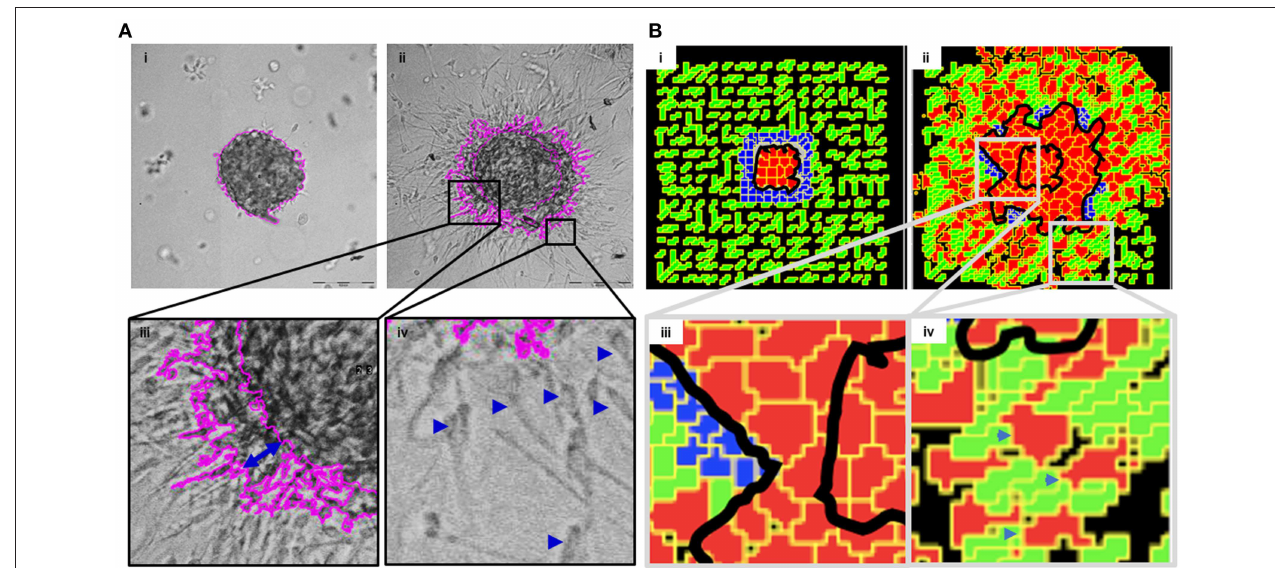
FIGURE 2 | Multiscale multicellular invasion of breast cancer cells in culture. (A) Representative phase contrast micrographs from time-lapse imaging of MDA-MB-231 cells showing multiscale invasion into fibrillar matrix. rBM-coated MDA-MB-231 clusters embedded within type 1 collagen (Ai) invade into the latter within 24h (Aii) . Cells show expansive migration [ (Aiii) ; double-headed blue arrow shows the extent of collective migration between initial boundary (0h) and final boundary (24h) of the cluster (boundaries shown in pink)]. Single mesenchymal cells are also observed in type 1 collagen [ (Aiv) right inset; blue arrowheads]. Scale bar: 200 µ m. (B) Multiscale invasion exhibited by computational model. Initial pattern [( Bi) ; MCS10; cancer cells (red) packed within a BM-like nonfibrillar matrix (blue) and further outward by fibrillar collagen-like matrix (green; inter-fibrillar gap = 3 unit pixels)], and final pattern [ (Bii) ; MCS 440] showing invasion of cells. In silico cells show expansive migration [ (Biii) left inset; bulk movement visible through the spatial gap between two black lines denoting boundary at initial MCS and final MCS]. Single cells are also observed in non-fibrillar ECM [ (Biv) right